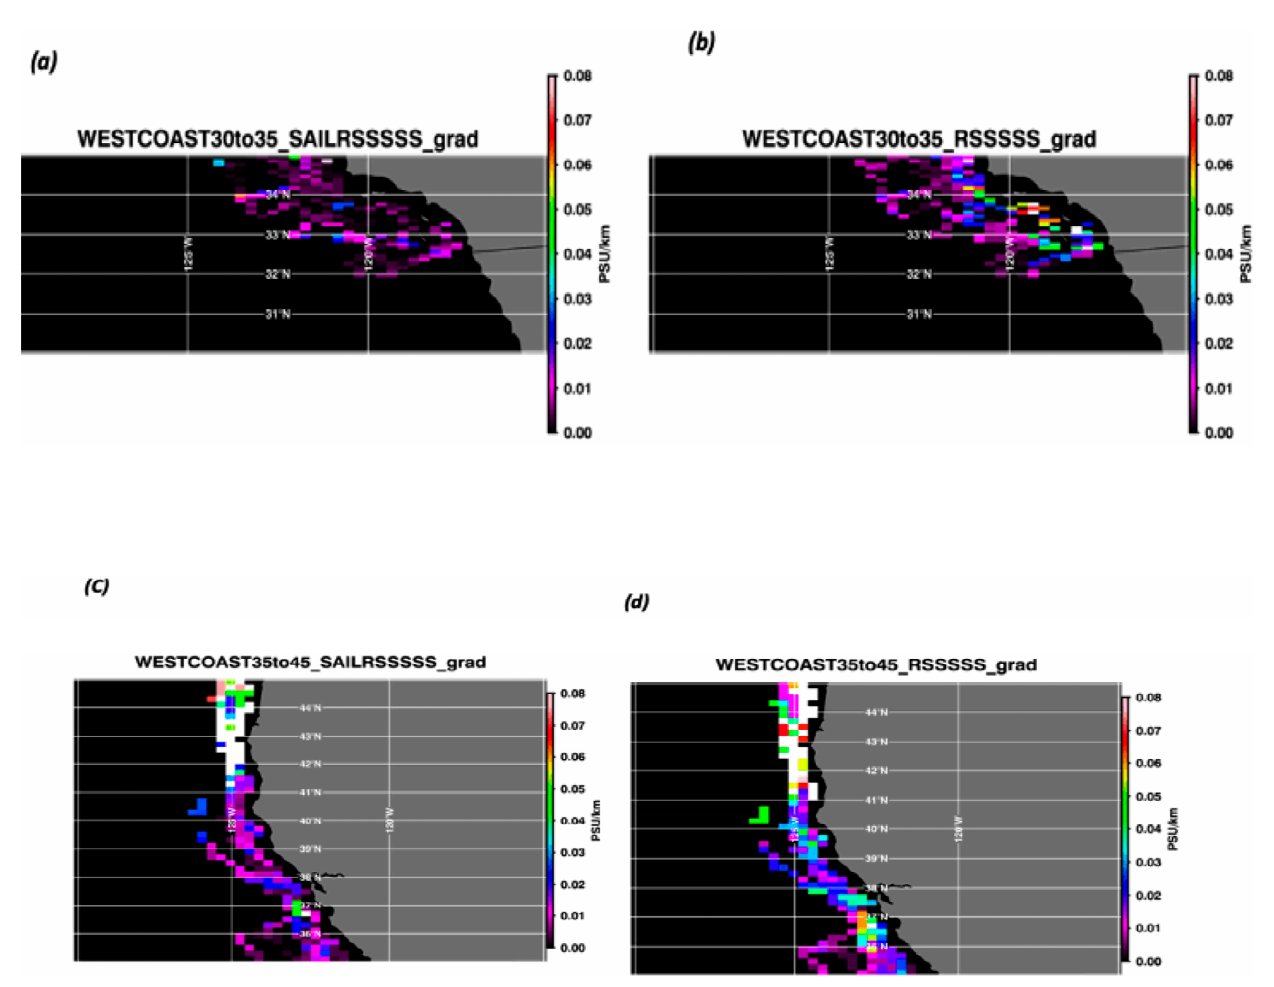
Figure 4. ( a – d ). ( a ) SAILSSS between 30°N to 35°N from the SBE based on the collocated RSSSSS and Saildrone deployment, ( b ) RSSSSS between 30°N to 35°N for the collocated RSSSSS product, ( c ) SAILSSS between 35°N to 45°N from the SBE/CTD based on the collocated RSSSSS and Saildrone deployment, and ( d ) RSSSSS between 35°N to 42°N for the co-located RSS SMAP product.